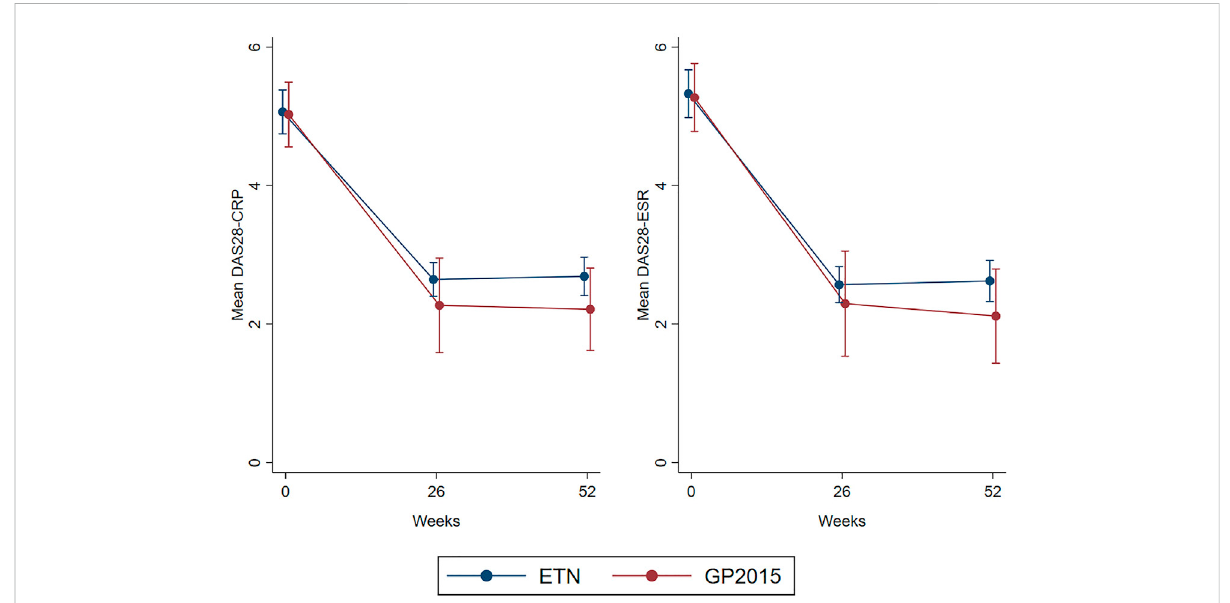
FIGURE 4 Mean change from baseline over 52 weeks in DAS28-CRP and DAS28-ESR scores of ETN and GP2015 groups. DAS28-CRP disease activity score 28 using c-reactive protein, DAS28-ESR disease activity score 28 using erythrocyte sedimentation rate, ETN etanercept originator (Enbrel ®